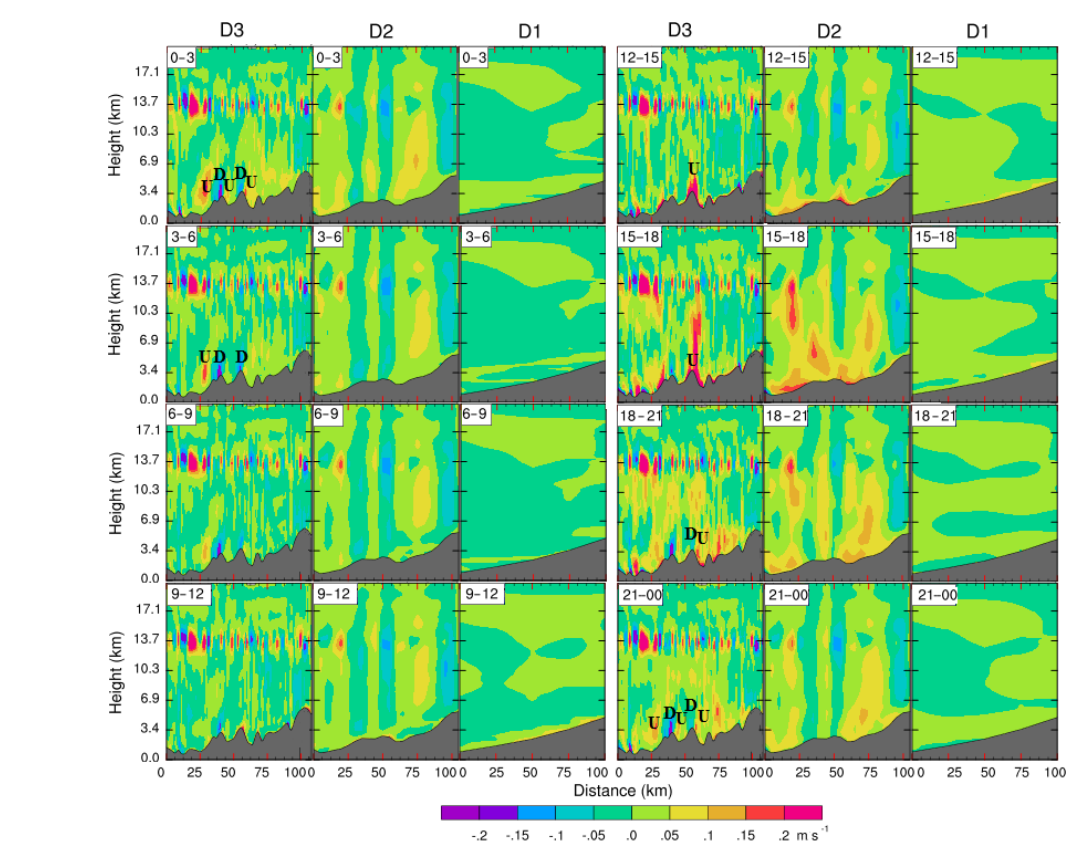
Figure 19. Three-hourly (local time) monsoon season average vertical velocity (ms − 1 ) at all three resolutions along the AB section, with topography in gray. A few points of upward and downward flows are also marked as U and D,